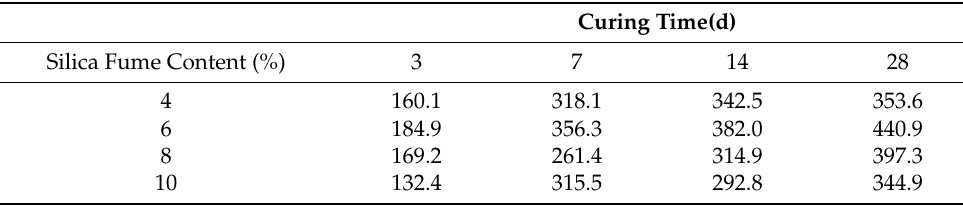
Table 5. The peak secant modulus for the